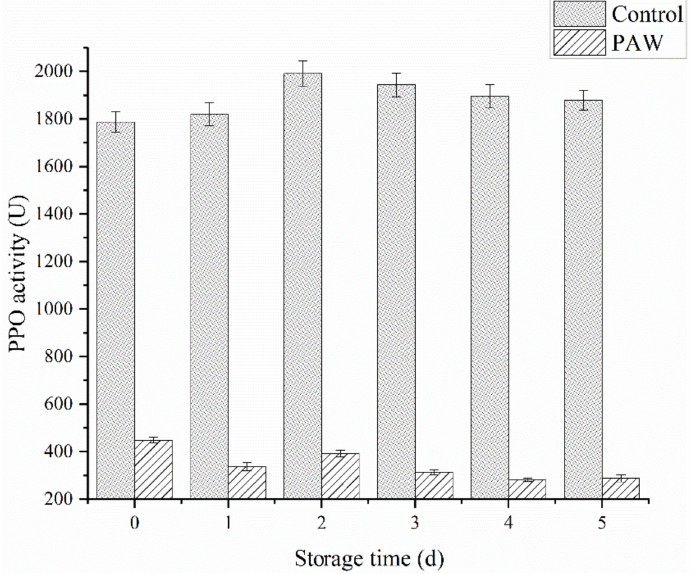
Figure 5. The PPO activity of the control and PAW groups during